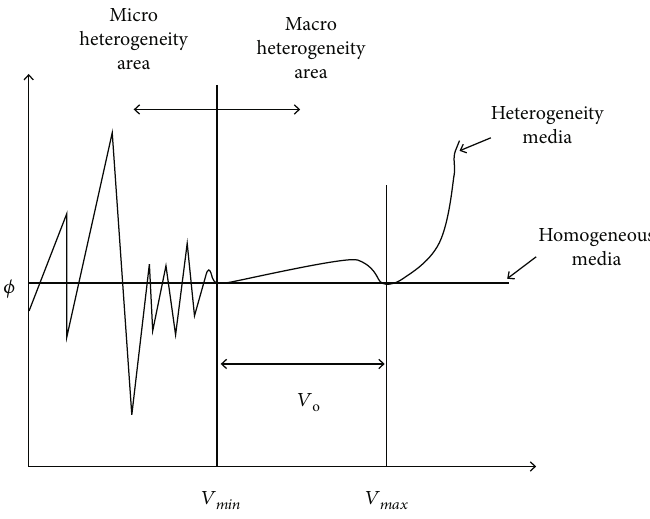
Figure 1: Porosity φ for di ff erent sizes of averaging volumes.